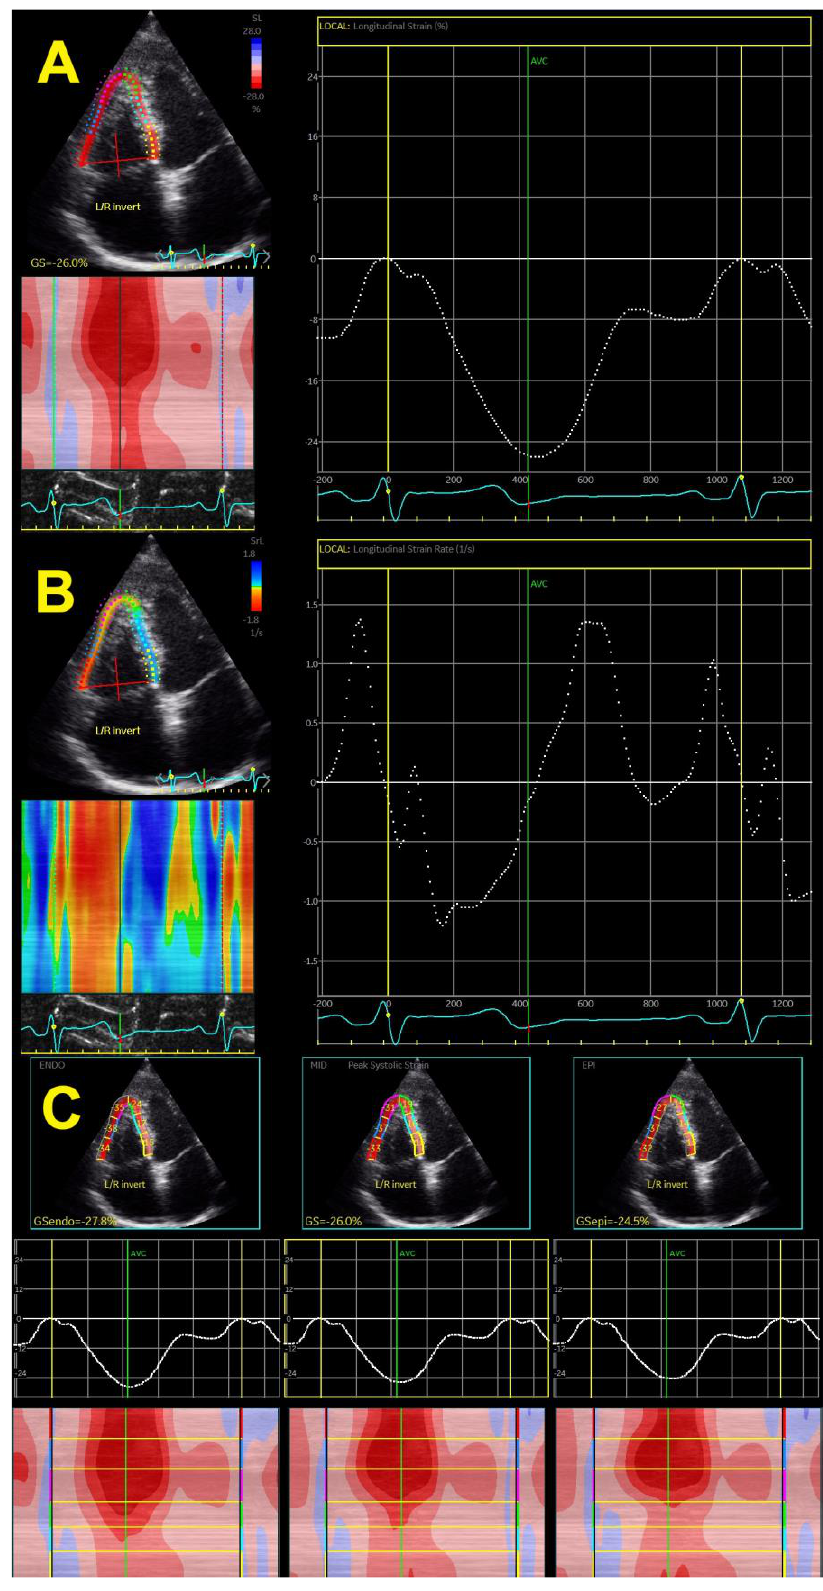
Figure 3. Two-dimensional global right ventricular strain ( A ), right ventricular strain rate ( B ), and layer-specific strain — endocardial, mid-myocardial, and epicardial ( C ). RA phasic function, determined by different segments of the longitudinal strain curve, showed impairment that correlated with systolic BP. Strain-derived RA phasic